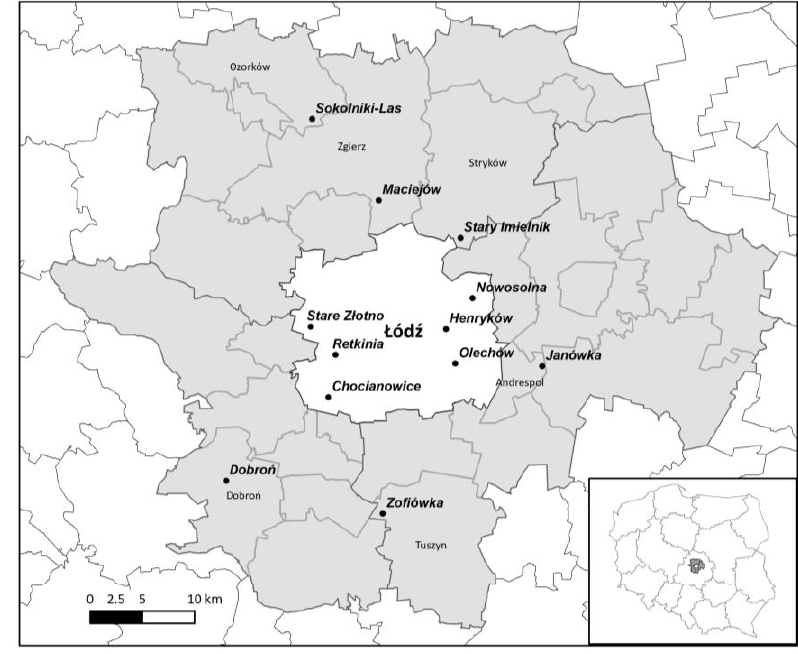
Fig. 1. Study area and location of settlements included in detailed analyses. Source: own